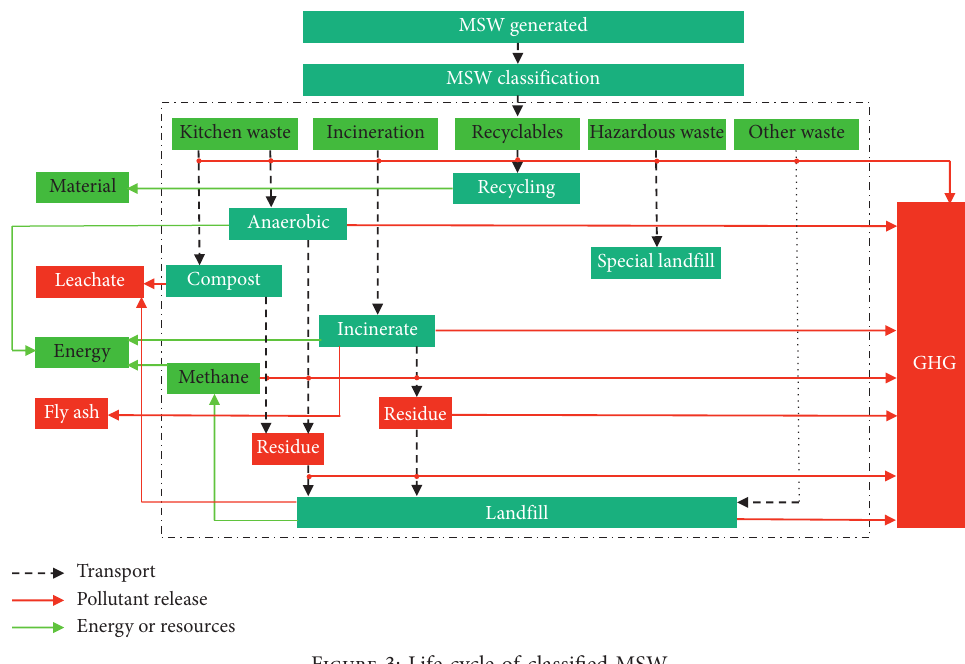
Figure 3: Life cycle of classified